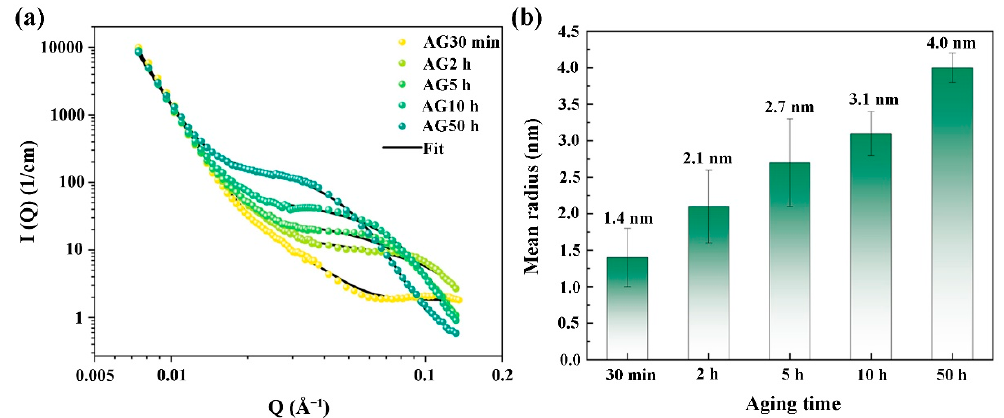
Figure 6. ( a ) SANS-intensity distribution as a function of momentum transfer Q for the steels aged at 500 °C for various times and ( b ) the mean radius of nanoparticles.